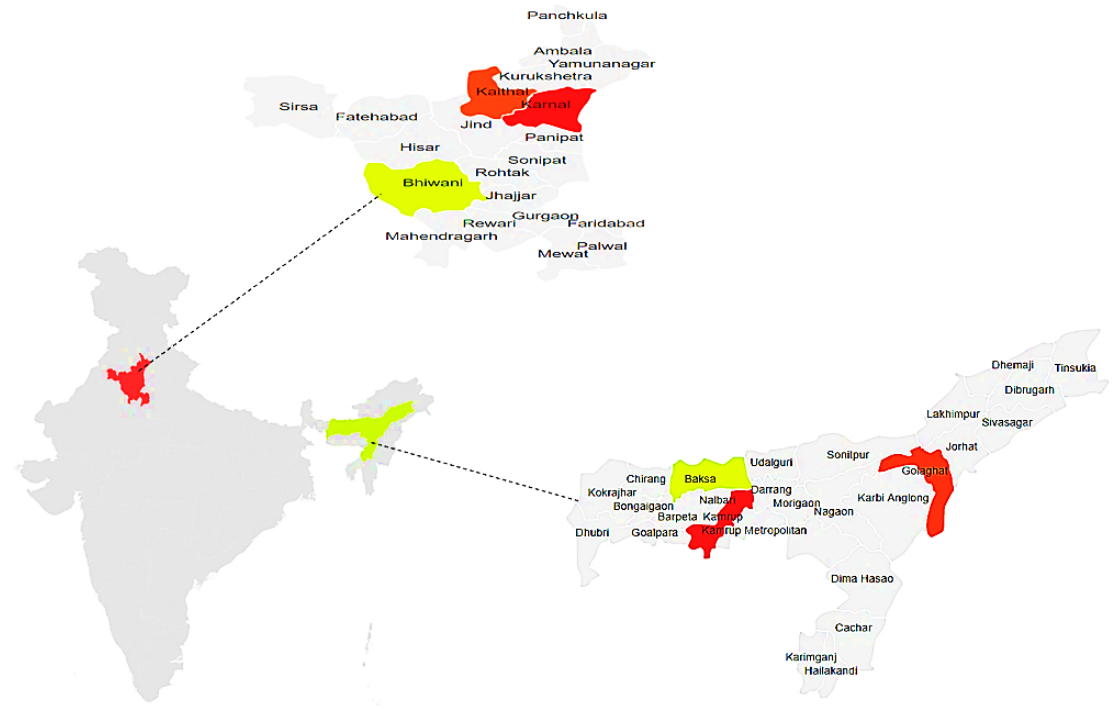
Figure 2. Map of India showing Haryana and Assam with the three districts within each state used for the study.